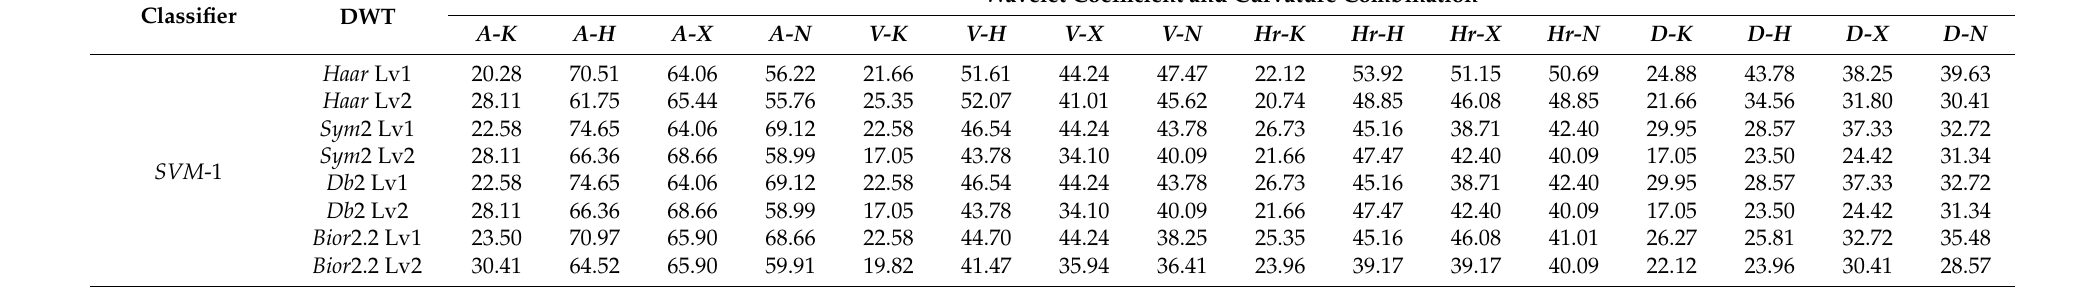
Table 6. The detailed accuracy (%) results of the combined DWT with a curvature-based method on the EYB dataset for the eye images using SVM -1. The combined methods produced wavelet coefficients with two decomposition levels and curvature-based variables (e.g., A - K (approximation with Gaussian curvature) until D - N (diagonal with min principal